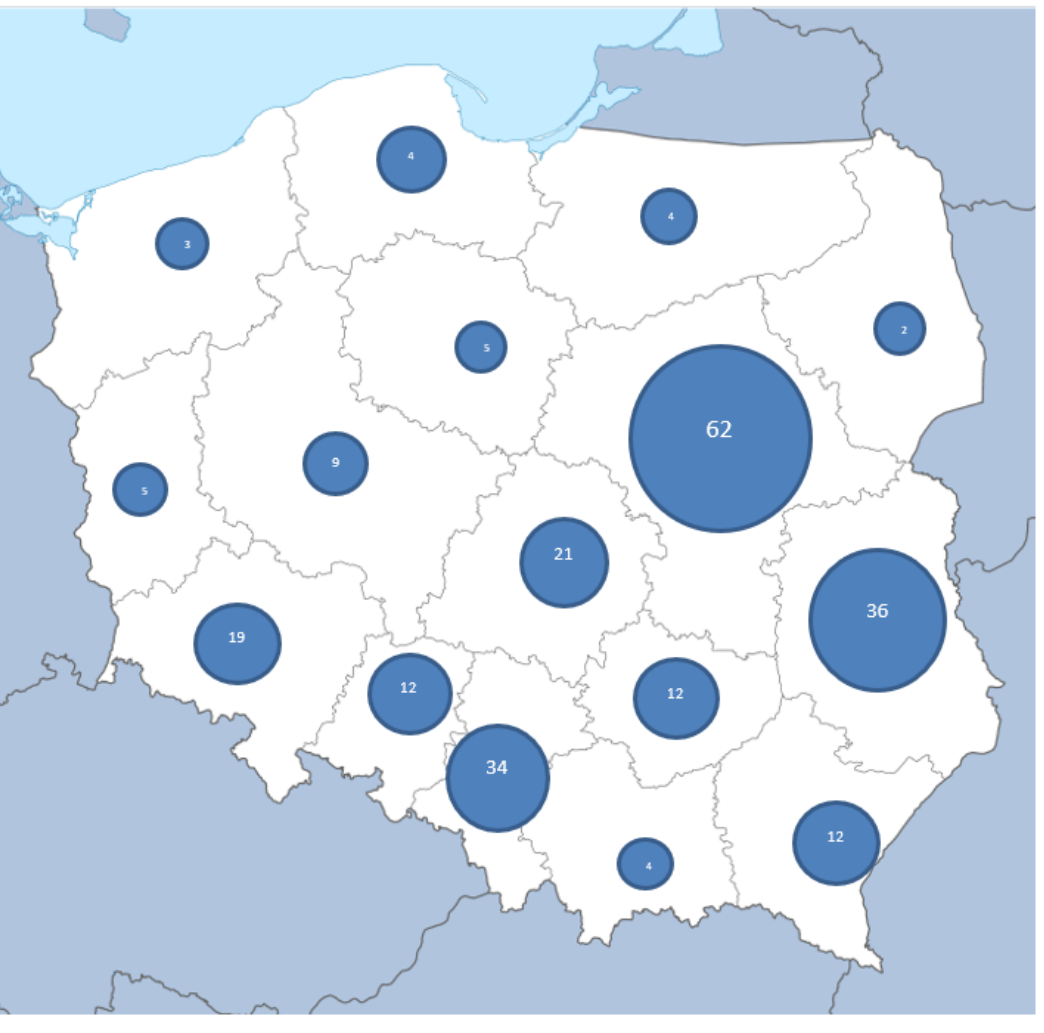
Figure 1. Geographical distribution of the studied cases throughout Poland (by regions)